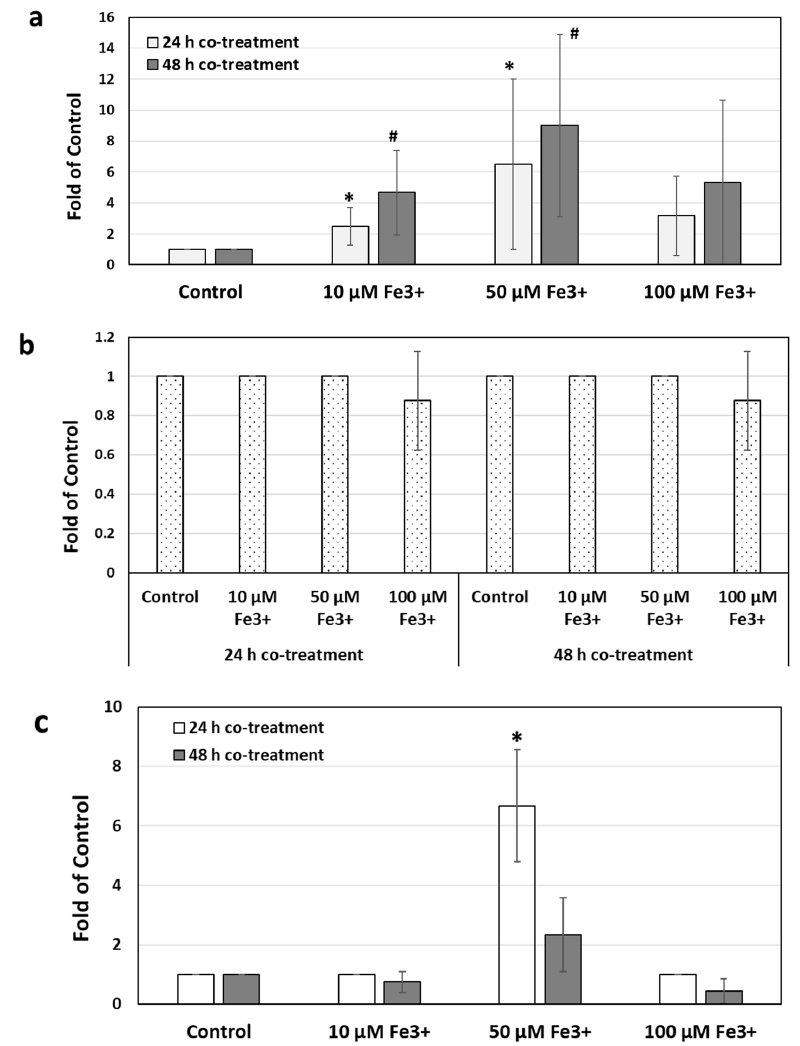
Figure 2. The presence of iron affected the MICs of metronidazole in different C. difficile strains. The effect of Fe 3+ on metronidazole MICs ( a ), vancomycin MICs ( b ), and fidaxomicin MICs ( c ) in C. difficile strain 9689. The antibiotic susceptibility was determined by the minimum inhibitory concentration (MIC). Each experiment was repeated at least three times independently and presented as mean ± SD. *, p < 0.05 compared to 24 h control; #, p < 0.05 compared to 48 h control. Fidaxomicin MICs also significantly increased in the presence of Fe 3+ . As shown in Figure 2c, after 24 h incubation, Fe 3+ (50 μ M) increased the MIC of fidaxomicin to 6.7 ‐ fold of control in the C. difficile 9689 strain but were still at values <1 μ g/mL, which would be considered susceptible. In strain R20291, there was an eightfold increase in MIC at 48 h regardless of the presence of iron and an approximately twofold increase under 10 μ M and 50 μ M iron concentrations. The fidaxomicin MIC was consistently 1 μ g/mL at 24 h under control conditions and tested three different iron concentrations (Supplementary Table S4). However, at 48 h, the MICs of control increased to 8 μ g/mL, and under 50 μ M Fe 3+ , the MIC further increased to 16 μ g/mL. Notably, a MIC value higher than 8 μ g/mL would be considered to have reduced fidaxomicin susceptibility [30,31]. Interestingly,